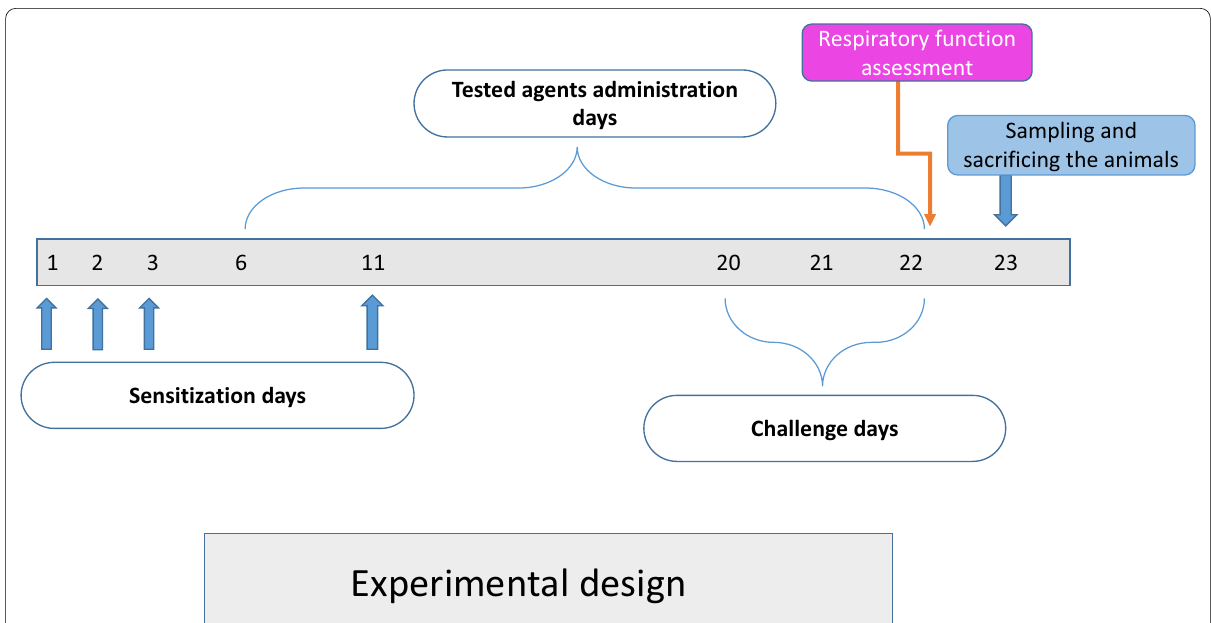
Fig. 1 A schematic illustration of the experimental design, showing the schedule of OVA sensitization and challenge also, drug